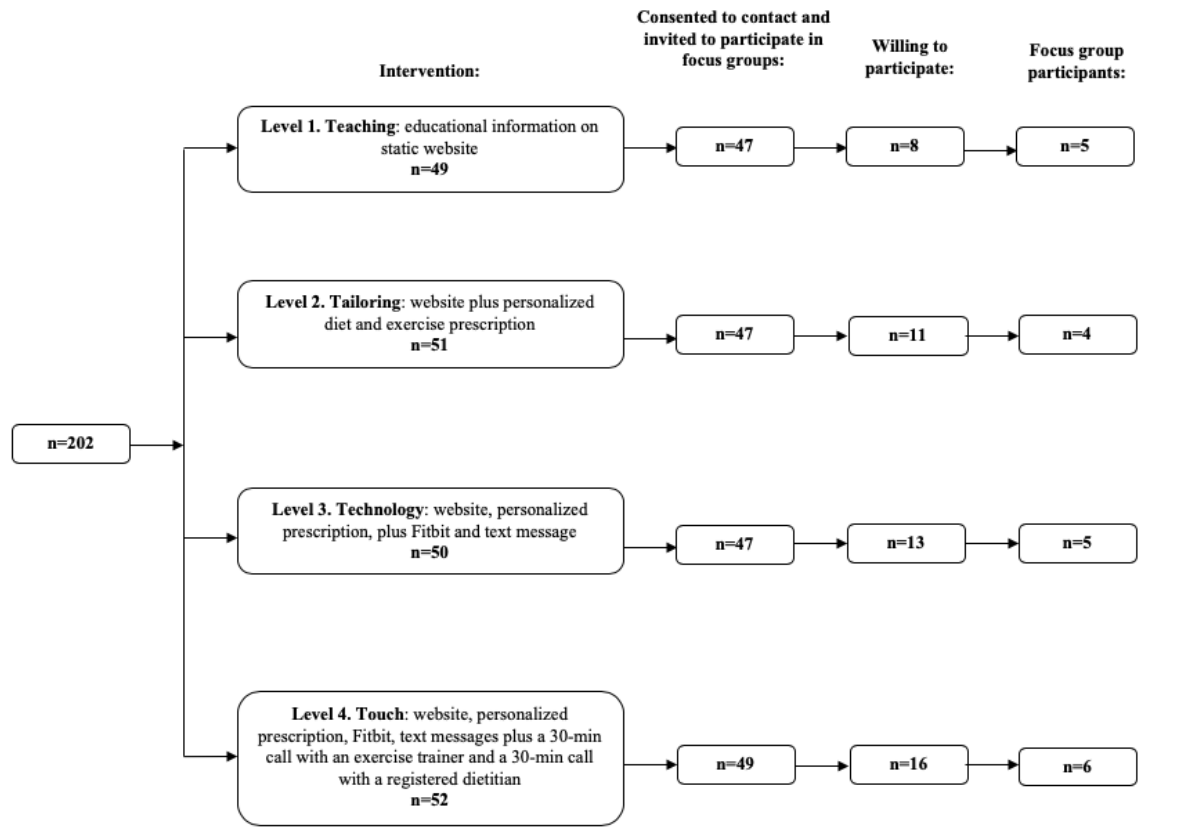
Figure 2. Community of Wellness study recruitment to intervention and focus